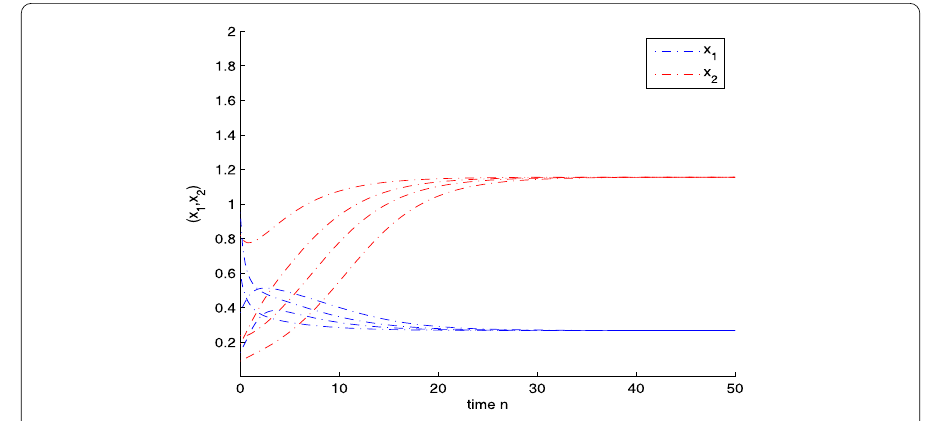
Figure 1 Dynamic behaviors of system (1.7) with the initial conditions ( x (0), y (0)) = (0.14,0.19),(0.37,0.009),(0.95,0.024), and (0.60,0.82),